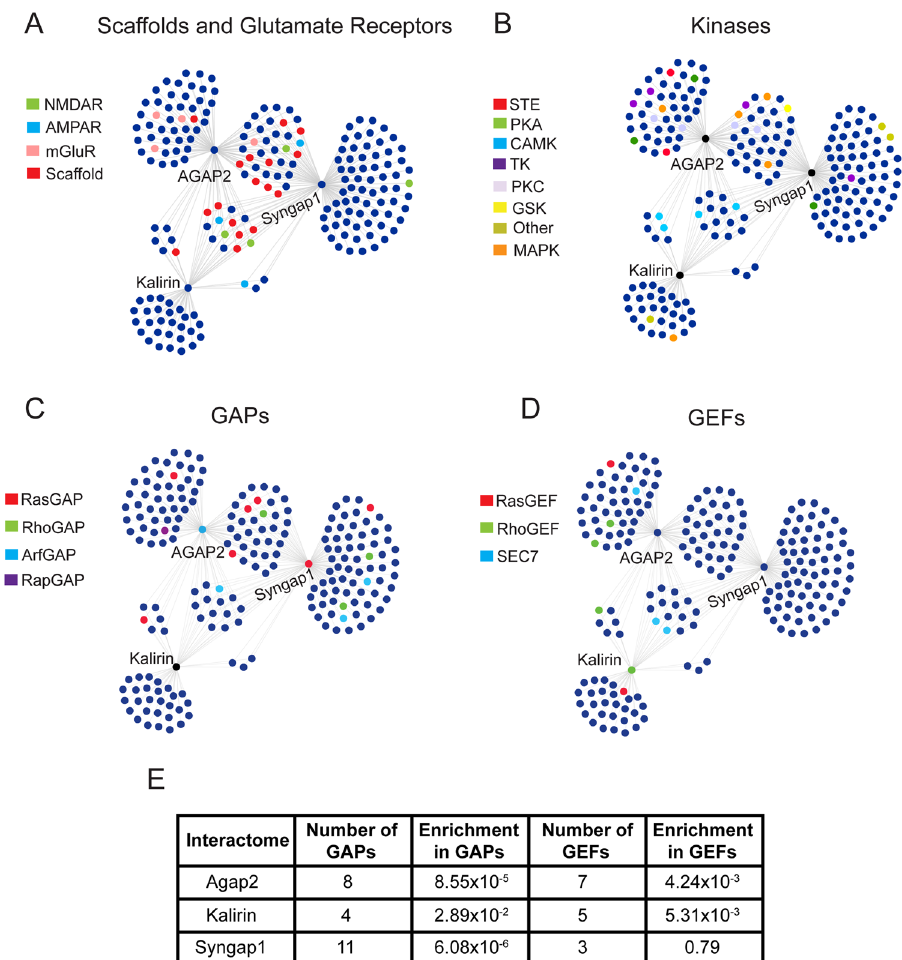
Figure 3. Distribution of Signaling Molecules within PSD Networks. Figure shows the distribution of several different classes of signaling molecules within the three PSD interactomes including: ( A ) Scaffolding proteins and glutamate receptors, ( B ) kinases, ( C ) GAPs, and ( E ) GEFs. ( F ) Enrichment of GAPs and GEFs within the PSD interactomes. P-values represent the results of one-tailed fisher exact tests followed by the Bonferroni correction for multiple comparisons. Abbreviations: CAMK, Ca 2 + /Calmodulin-dependent protein kinase; GAP, GTPase activator protein; GEF, guanine nucleotide exchange factor; GSK, glycogen synthase kinase; MAPK, mitogen-activated protein kinase; SEC7, domain in homologues of S. cerevisiae Sec7; STE, homologs of Ste7, Ste11, and Ste20; TK, tyrosine kinase; PKA, protein kinase A; PKC, protein kinase